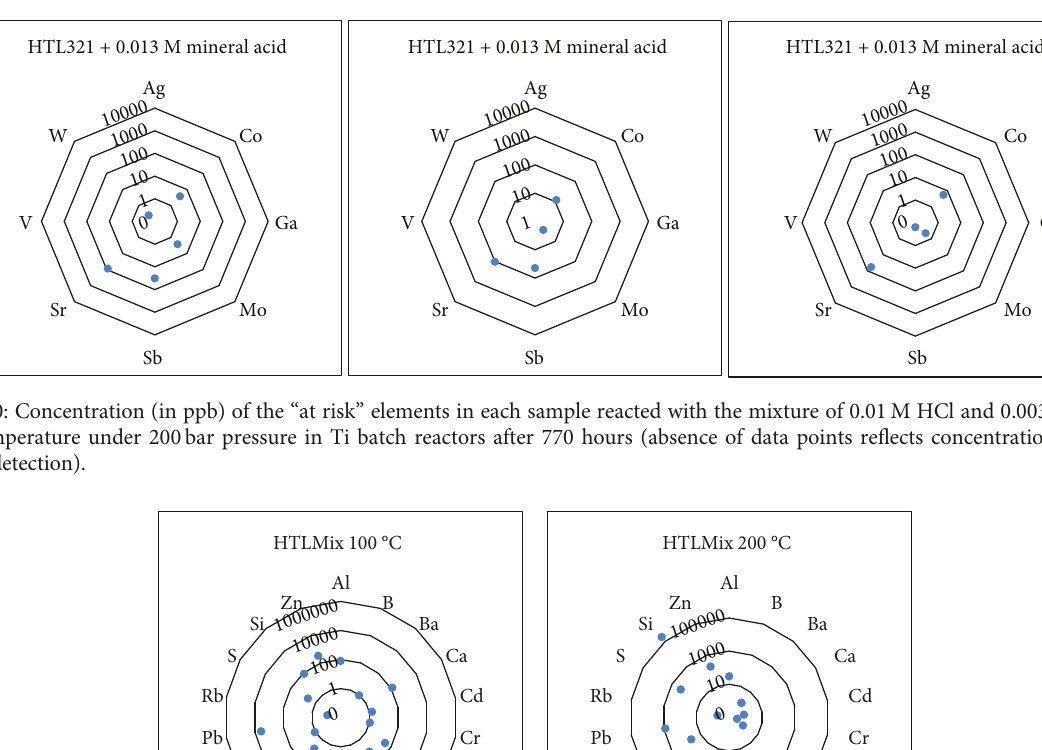
at 100 ° C and 200 ° C 3